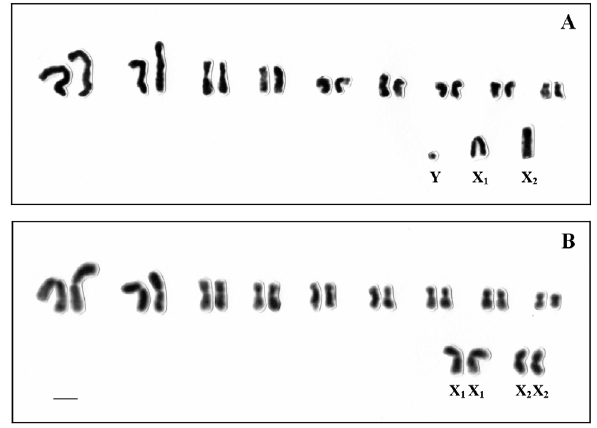
Figure 1 - Mitotic chromosomes of Cicindela argentata . (A) Male karyogram, 2n = 18 + X 1 X 2 Y; (B) Female karyogram, 2n = 18 + X 1 X 1 X 2 X 2 . Bars = 4 µ m.